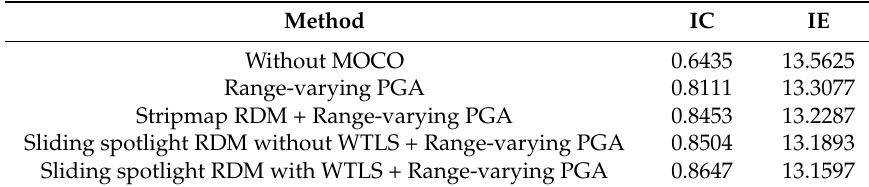
Table 2. Image Contrast (IC) and Image Entropy (IE) of the typical area in Figure 5.